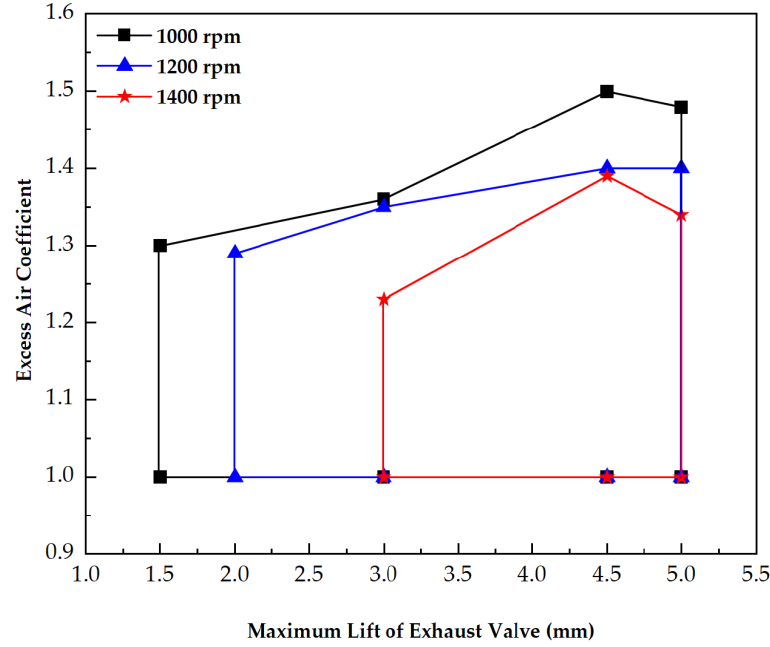
Figure 4. The range of λ under different exhaust valve lifts at 1000 rpm, 1200 rpm and 1400 rpm.